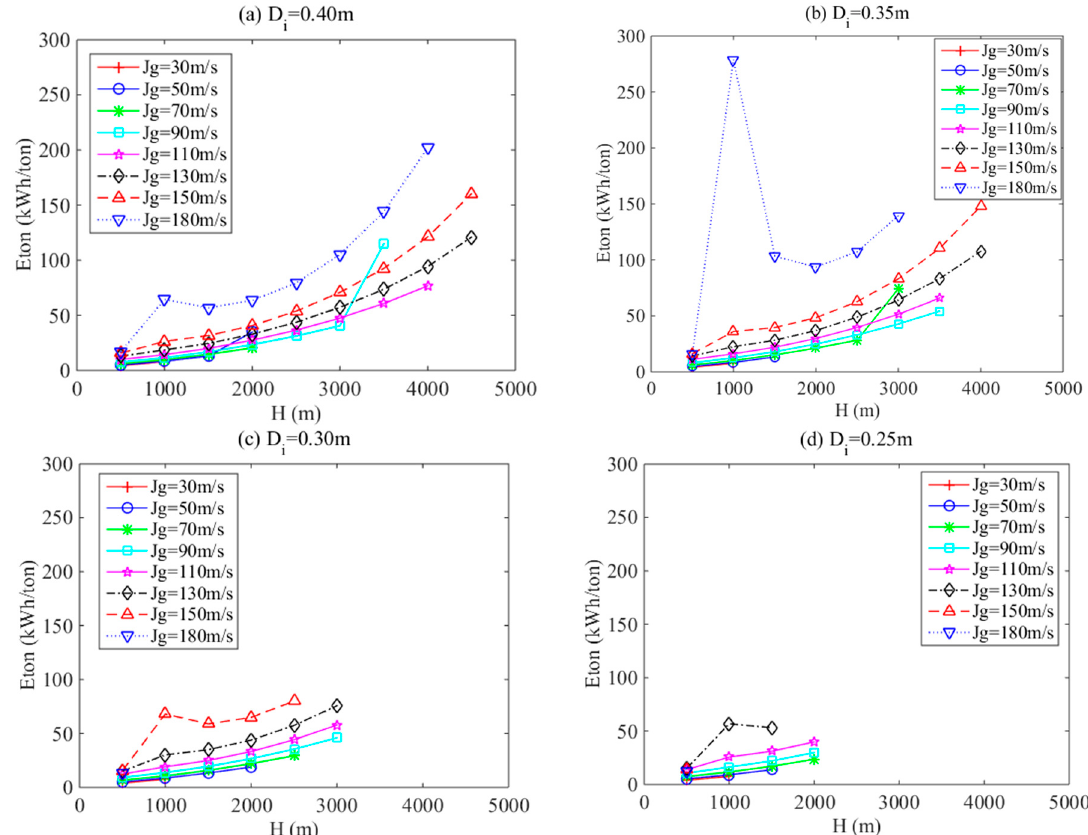
Figure 9. Figure of energy consumption per tonnage of mineral Eton influenced by pipe diameter D i at different mining depth H and gas flux rate Jg . The pipe diameter of ( a – d ) are 0.40, 0.35, 0.30, 0.25 m, respectively.